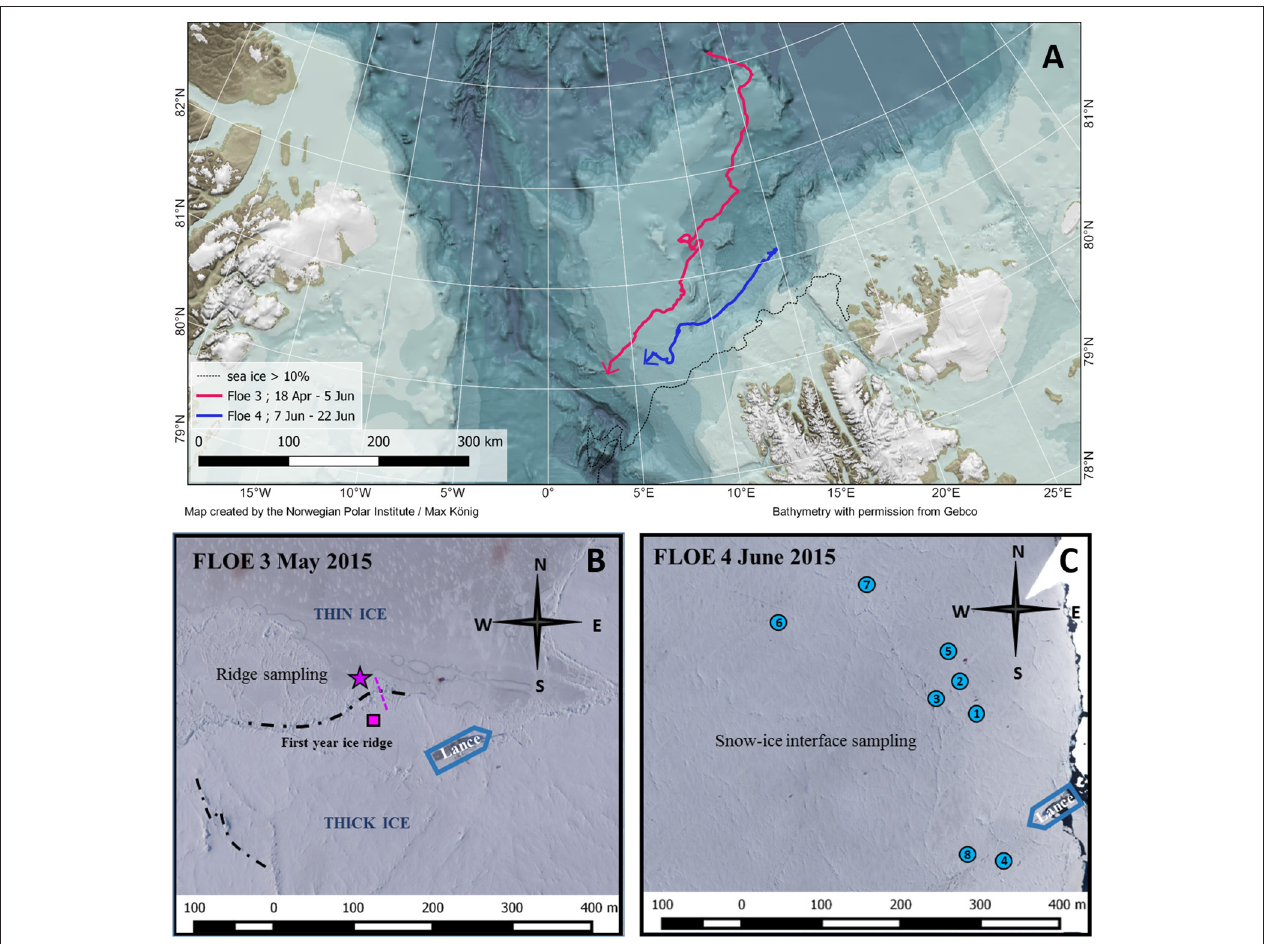
FIGURE 1 | (A) Study area with bathymetry for the N-ICE2015 expedition. The drift trajectories are shown in thick magenta (Floe 3) and blue (Floe 4) lines. The black dotted line indicates the ice edge ( > 10% ice coverage) position on 25 May 2015. Map created by Max König for the Norwegian Polar Institute. Bathymetry with permission from IBCAO (Jakobsson et al., 2012). (B) Aerial image of the study area during Floe 3 (image taken on 23 May 2015) and location of ridge sampling. The pink line indicates the transect sampled across the ridge and the star the sampling site from which the videos were recorded and the biomass estimates calculated. The pink square indicates the low biomass side of the ridge. (C) Aerial image of the study area during Floe 4 (image taken on 14 June 2015) and locations of snow-ice interface sampling. Vasilii Kustov and Sergey Semenov (Arctic and Antarctic Research Institute. St. Petersburg.